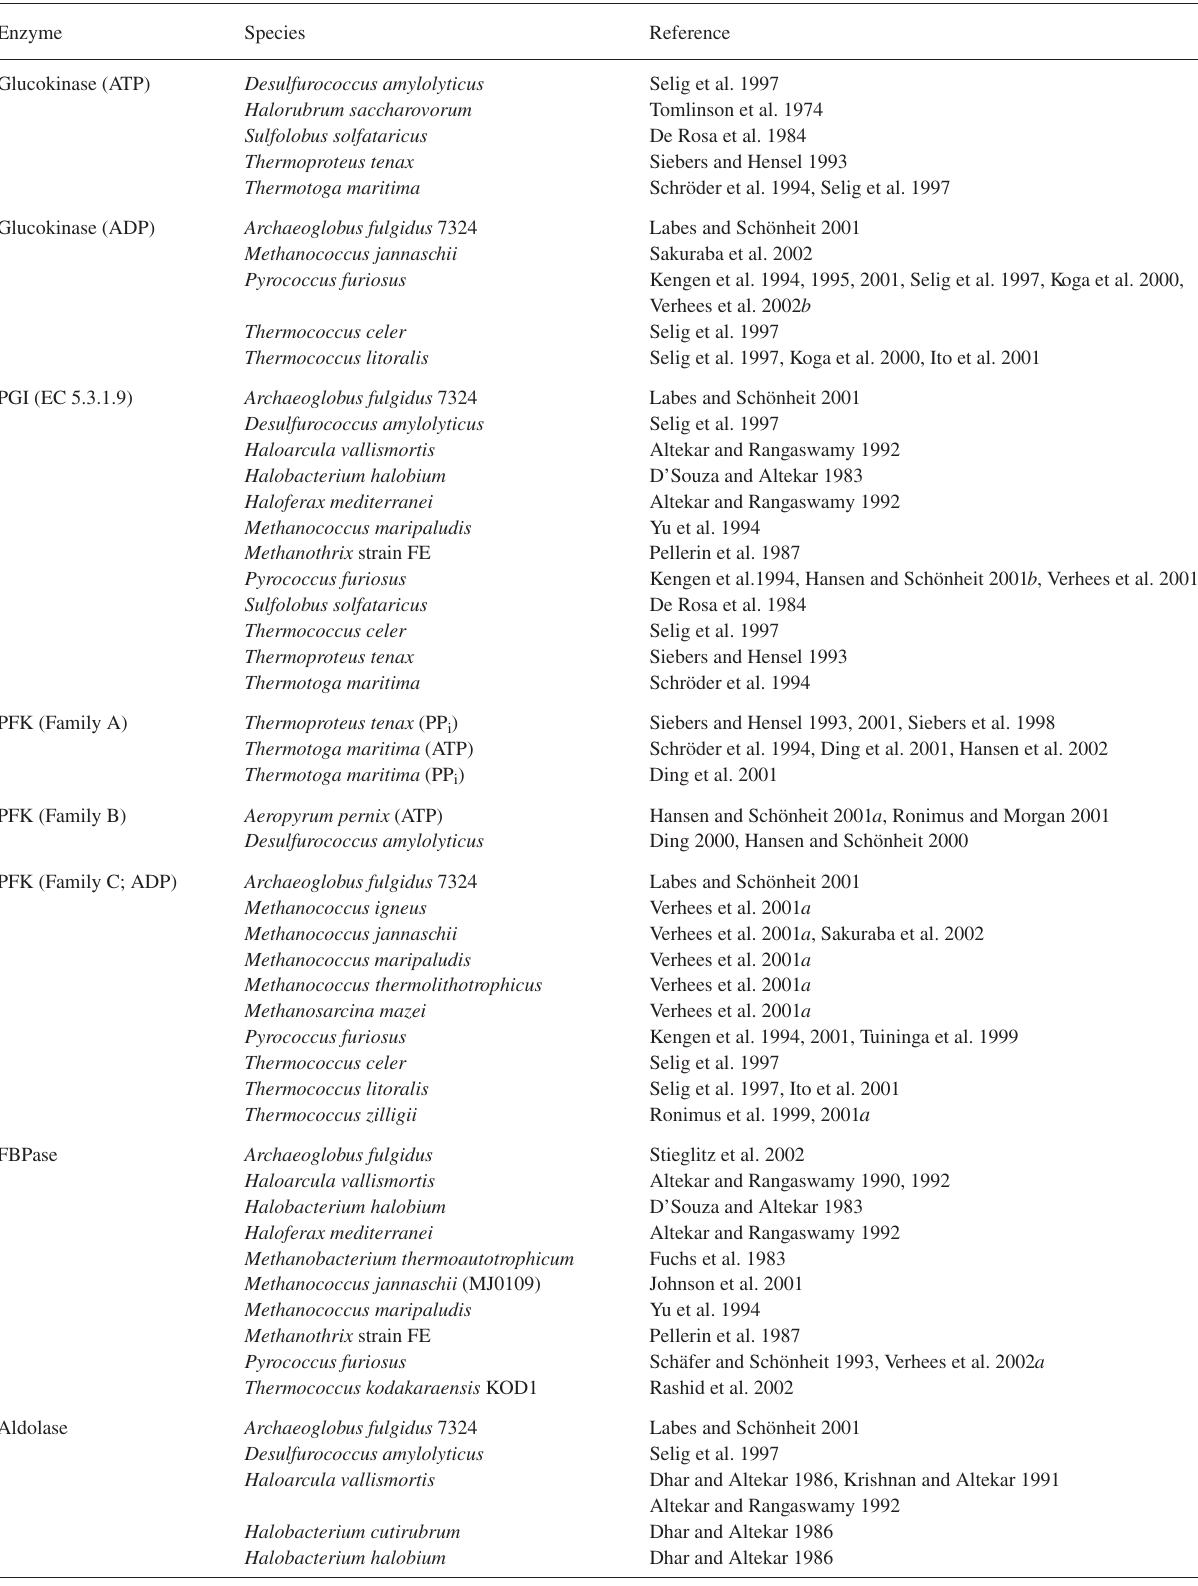
Table 2. Detection of glycolytic enzyme activities in hyperthermophilic prokaryotes and mesophilic archaea.